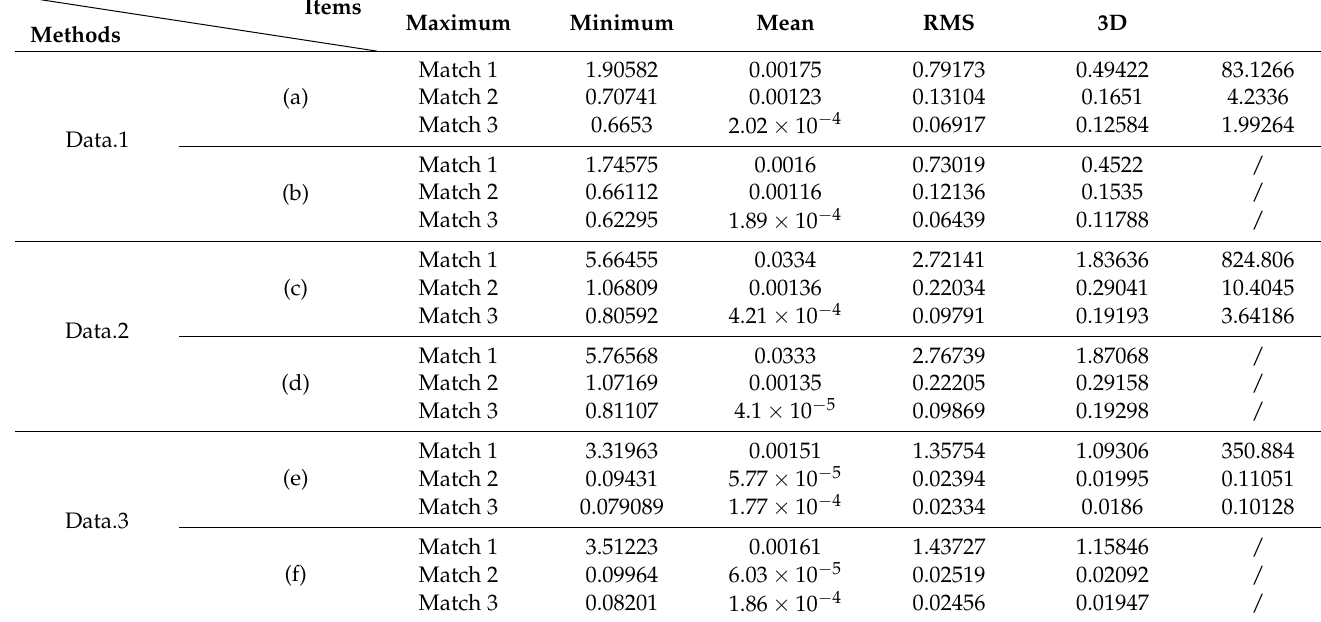
Table 3. Statistics with the error of 3D